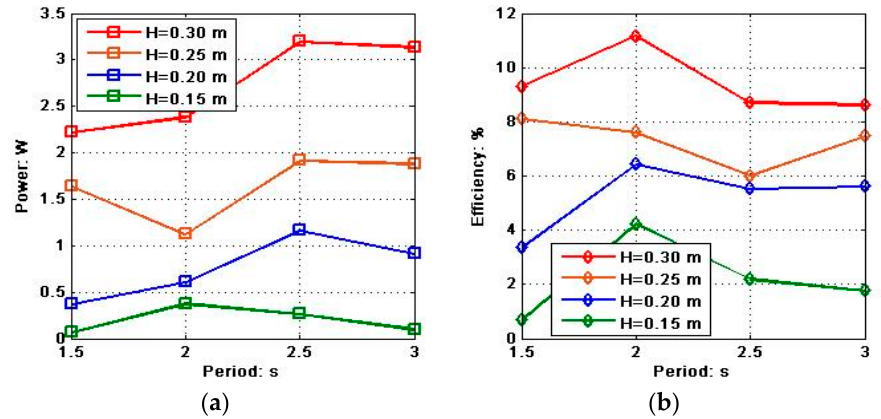
Figure 15. Generation performance of the ACWEC with different wave heights, M 1 = 14.21 kg: ( a ) power curve; ( b ) efficiency curve.